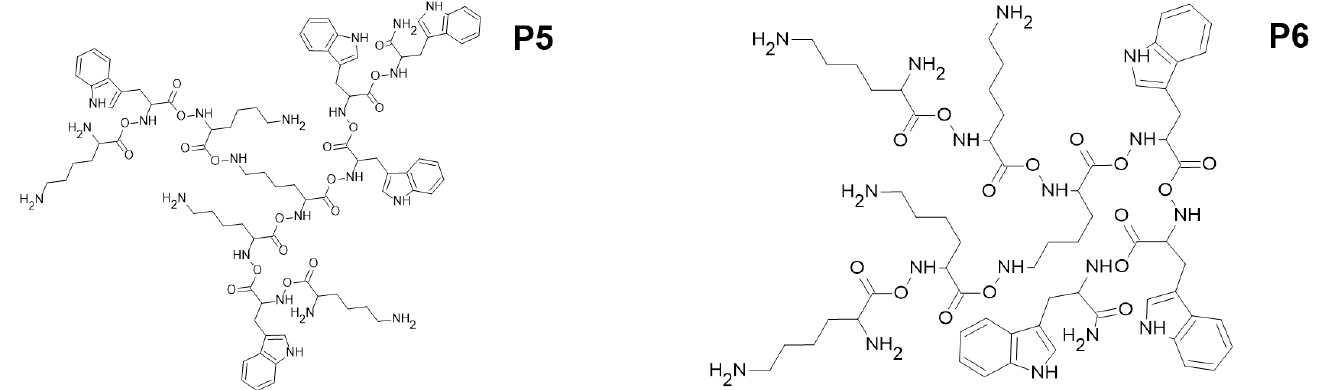
Figure 1. Structures of tested peptides P2, P4–P6. P2, P4–P6 are the abbreviations of the evaluated peptides described in the text [18].